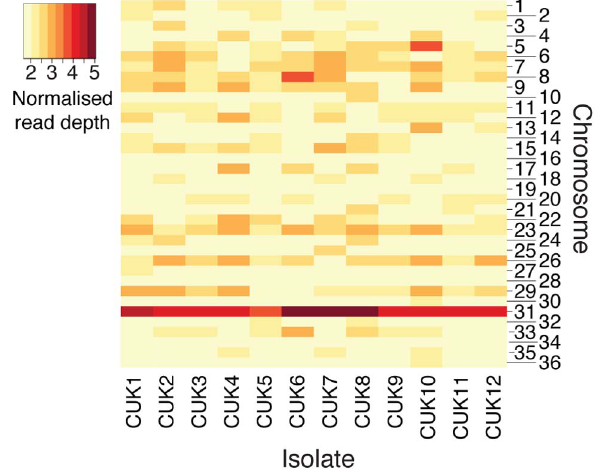
Figure 4. Aneuploidy in the CUK strains. The heatmap shows chromosomal copy number for all 36 chromosomes across the 12 CUK strains, based on normalized chromosome read-depth. Copy number varies from disomic (light yellow) to pentasomic (dark-red).